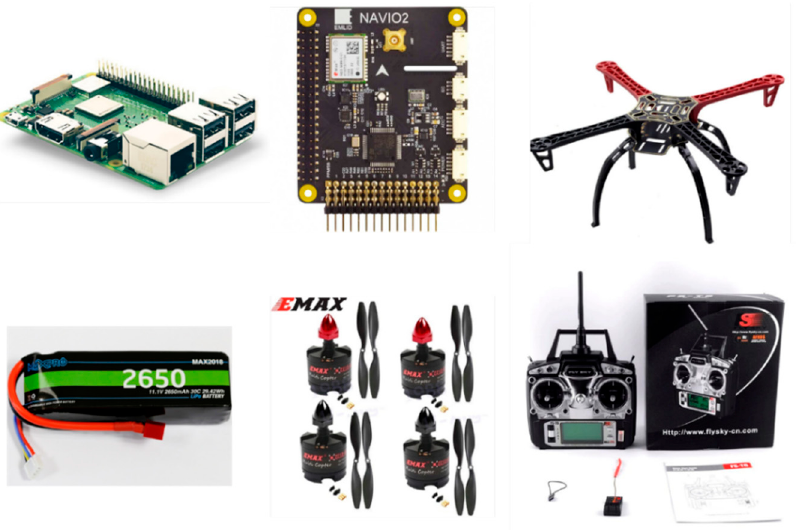
Figure 3. Hardware components used to build the drone.